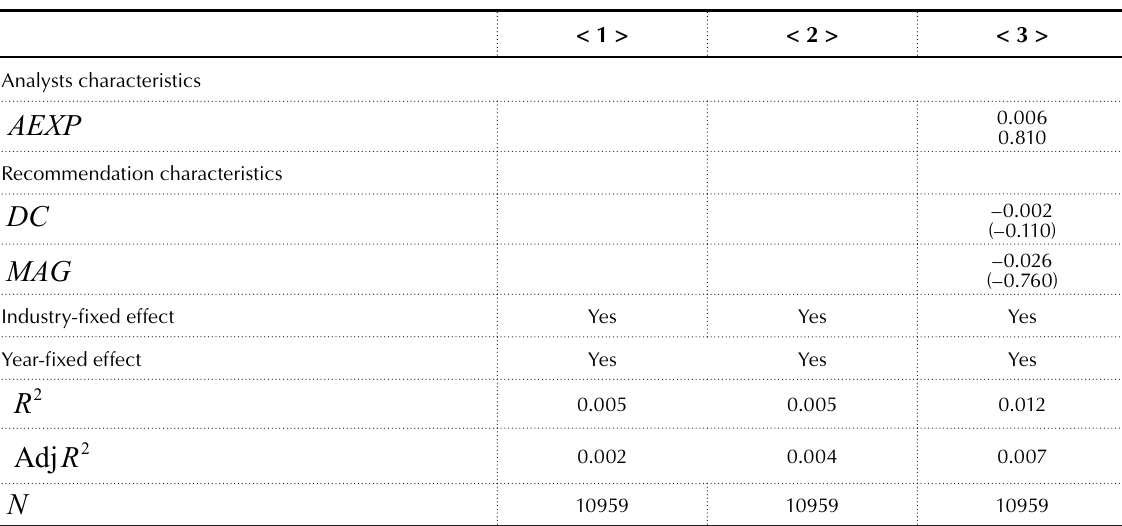
Table 3 (cont.). Ambiguity and two-day buy-and-hold abnormal returns